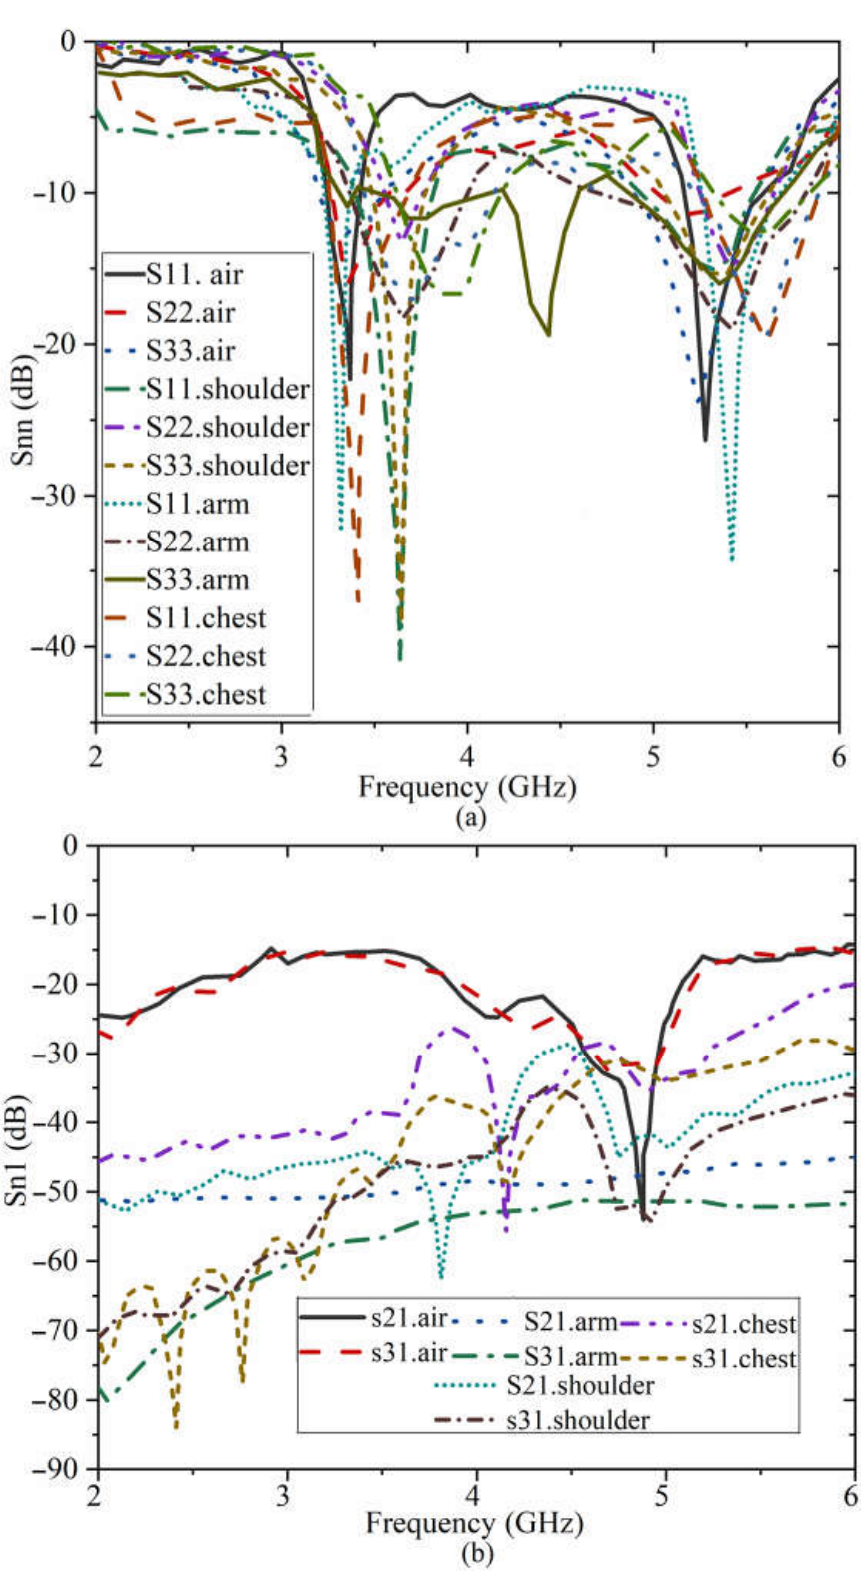
Figure 13. The S-parameter results of the proposed antenna on tissue body and voxel shown in Figure 12, ( a ): Snn is the reflection coefficient, and ( b ): Sn1 is the transmission coefficient. Figures 14 and 15 show the antenna’s radiation pattern on body tissue and voxel body, respectively. Figure 14 depicts that the antenna radiates outwards and mainly in